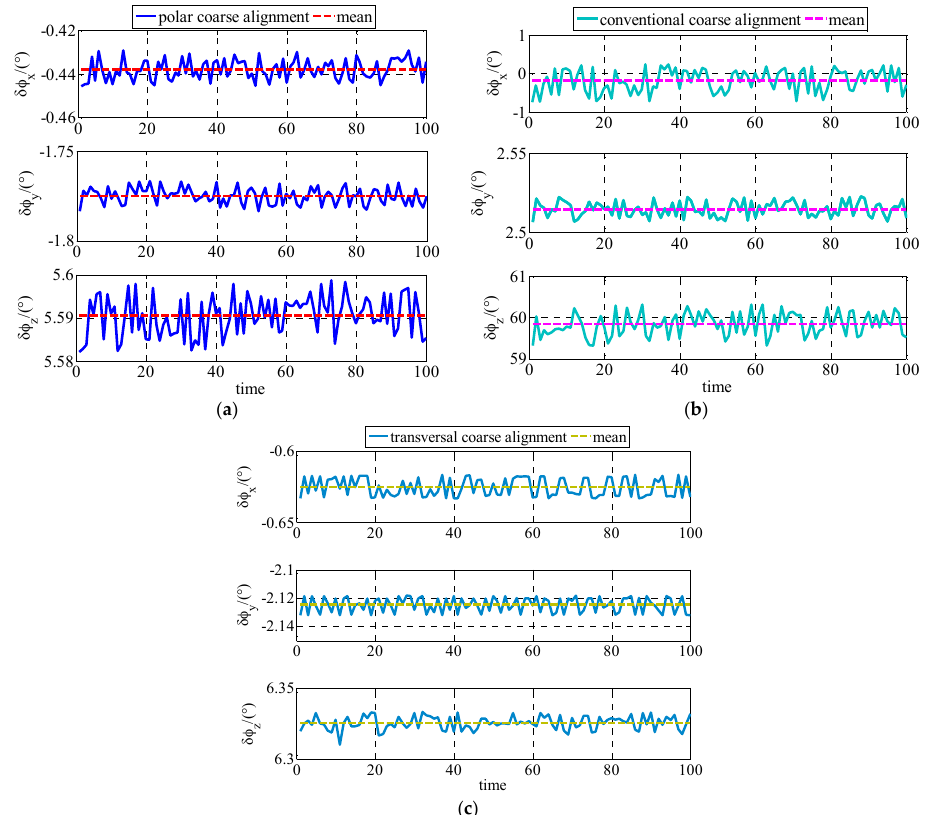
Figure 5. Estimates of φ G in experiment: ( a ) Estimates of φ G based on polar coarse alignment algorithm for polar UUV navigation; ( b ) Estimates of φ G based on conventional coarse alignment algorithm for polar UUV navigation; ( c ) Estimates of φ G based on transversal coarse alignment algorithm for polar UUV navigation.